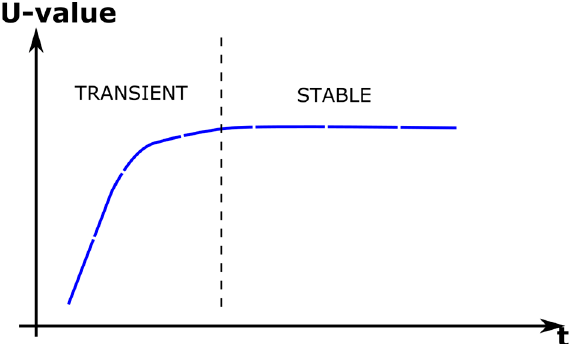
Figure 3. Schematic evolution of U-value with continuous thermal measurement.